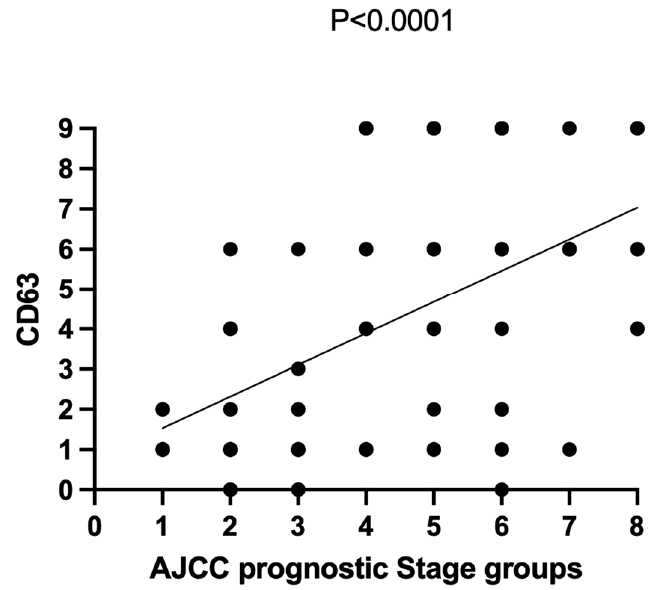
Figure 3. Association between CD63 expression and AJCC prognostic stage groups via Pearson’s chi-squared test ( χ 2). Pearson’s χ 2 = 0.27; p < 0.0001.